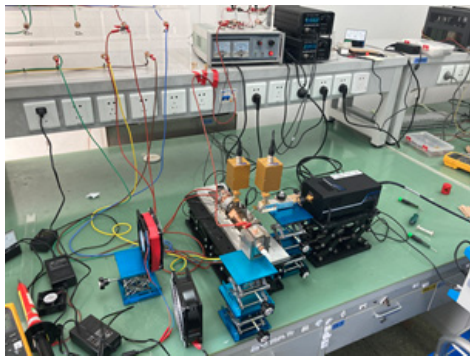
Figure 15. Test system.